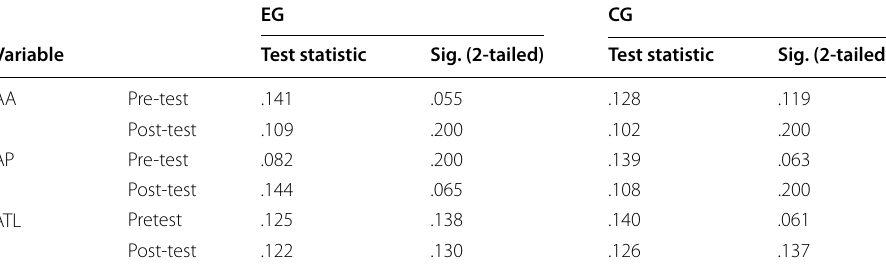
Table 2 K‑S test for pre‑test and post‑test of CG and EGs